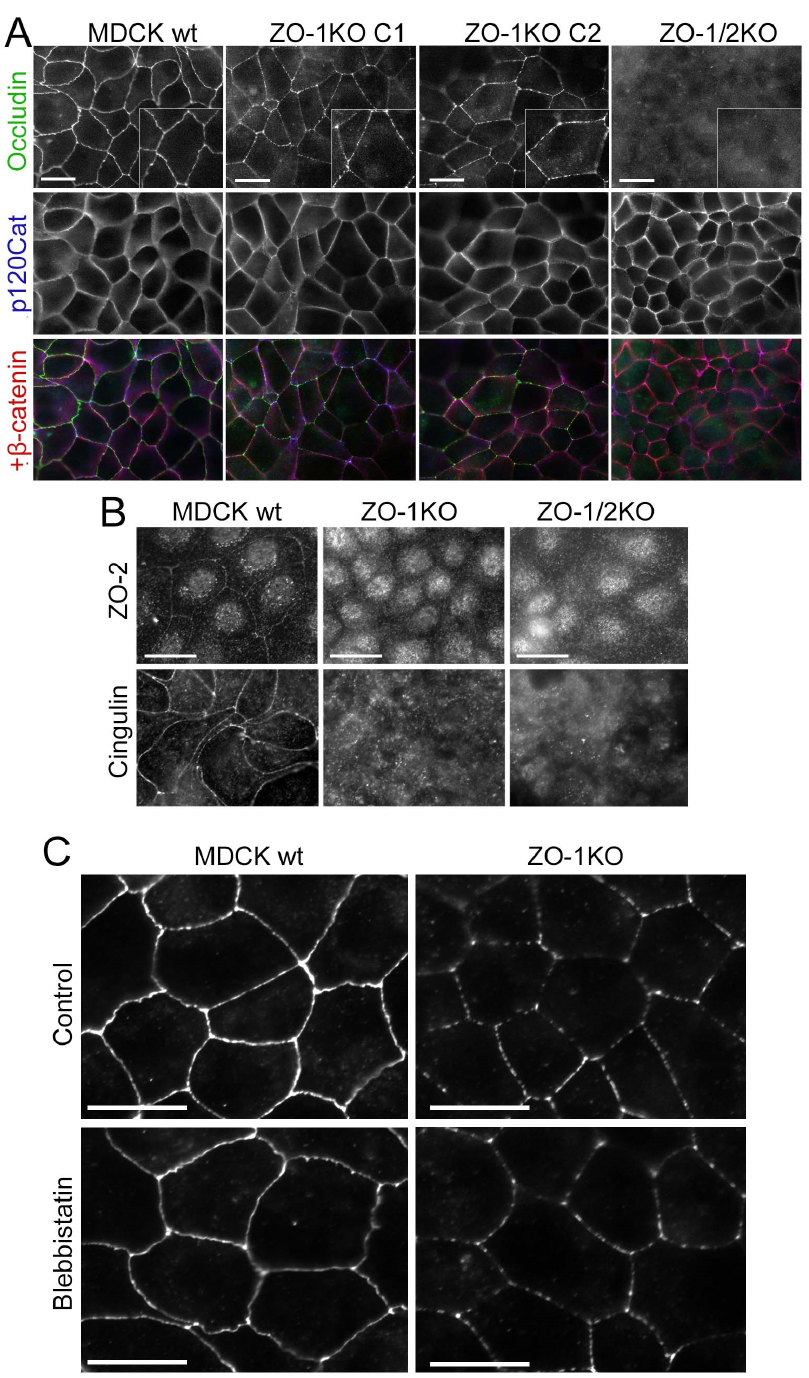
Figure 7. ZO-1 and ZO-2 have distinct functions in TJ assembly. Analysis of wild-type and knockout MDCK cells seeded on glass and grown to confluence for 5 days by epifluorescence microscopy. Insets show higher magnifications to illustrate the discontinuous staining of occludin ( A , B ) Cells were stained for the junctional proteins. Note, occludin remained discontinuously distributed and recruitment of cytosolic TJ proteins was strongly attenuated. ( C ) Wild-type and ZO-1KO MDCK cells were treated with blebbistatin and then fixed and stained for occludin. Note, the distribution of occludin remained discontinuous in blebbistatin-treated ZO-1KO cells, indicating that the disrupted occludin arrangement was not due to the increased myosin activity. Magnification bars, 20 μ m.